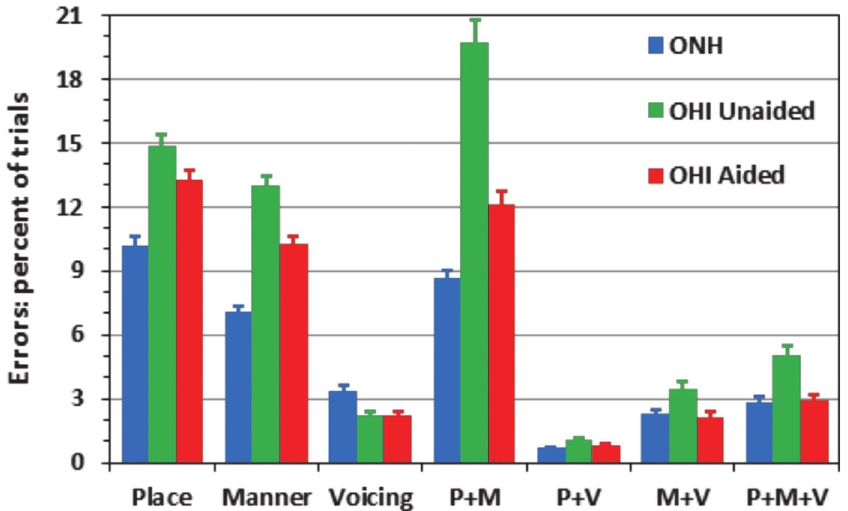
Fig 5. Incidence of different types of phonetic errors for ONH listeners, and for unaided (green) and aided (red) OHI listeners. Error bars show standard errors.